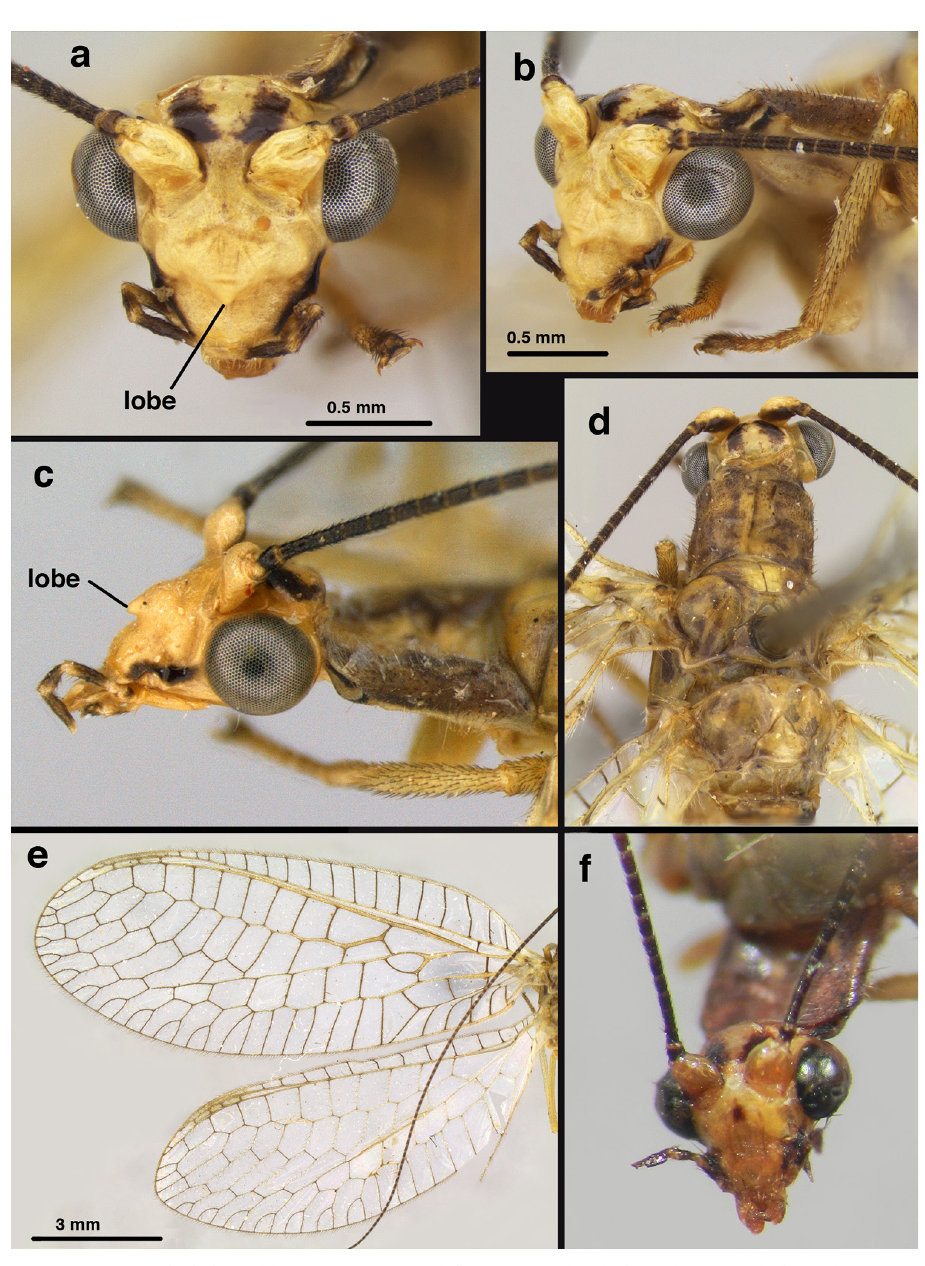
Figure 18. Ungla bolivari -like species: External features, ( a ) head, frontal ( b ) head, frontolateral ( c ) head, lateral ( d ) head, thorax, dorsal ( e ) wings, left ( f ) head dorsofrontal. ( a–e Venezuela, Boconó, male, MIZA; f Venezuela, Lara, Yacambu, female, MIZA; all: images,